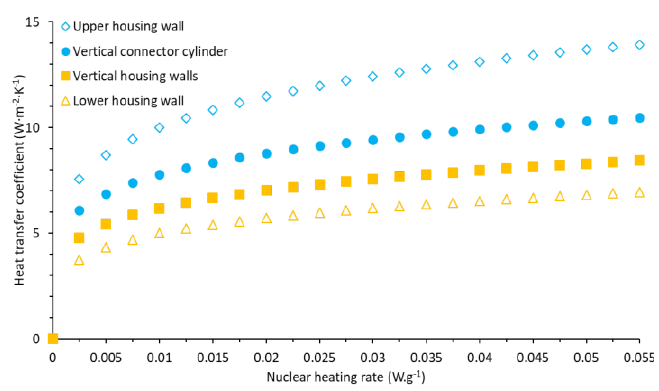
Fig. 2. Various heat transfer coefficient values calculated by COMSOL as a function of the nuclear heating rate for a fluid temperature of 40°C.